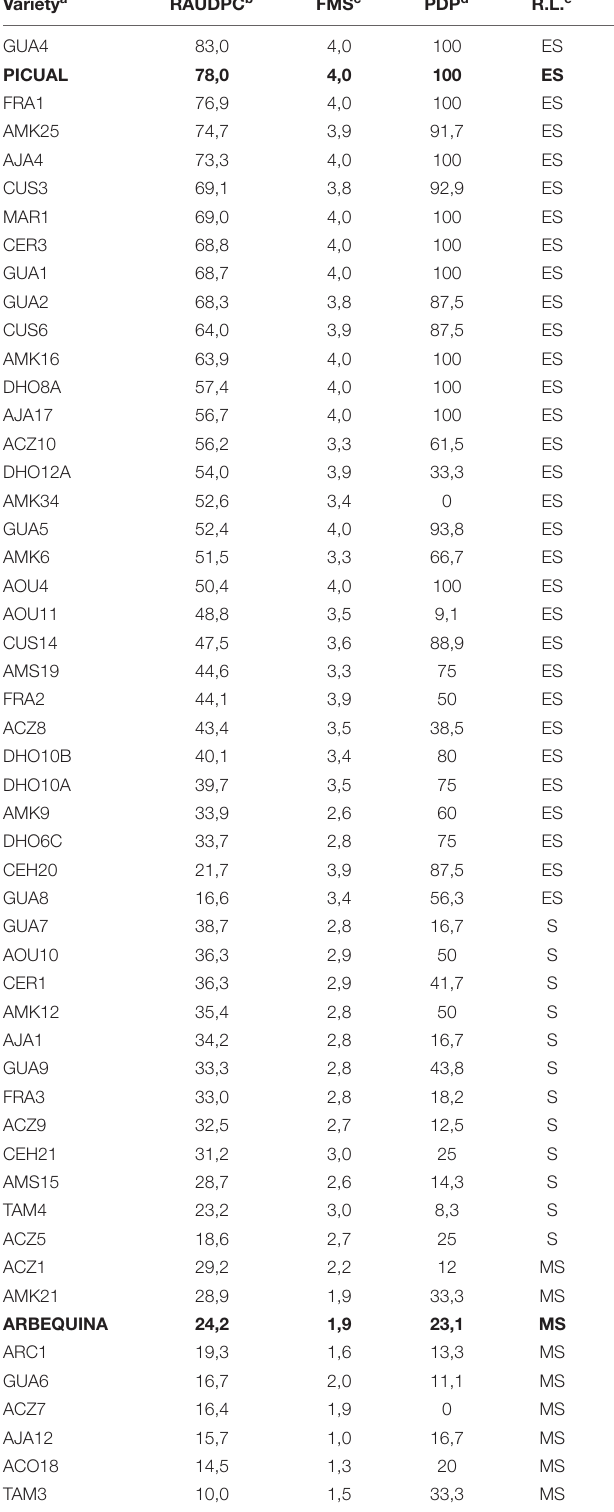
TABLE 1 | Mean disease parameters assessed in the wild olive genotypes inoculated with the defoliating isolate VD117 of Verticillium dahliae . Variety